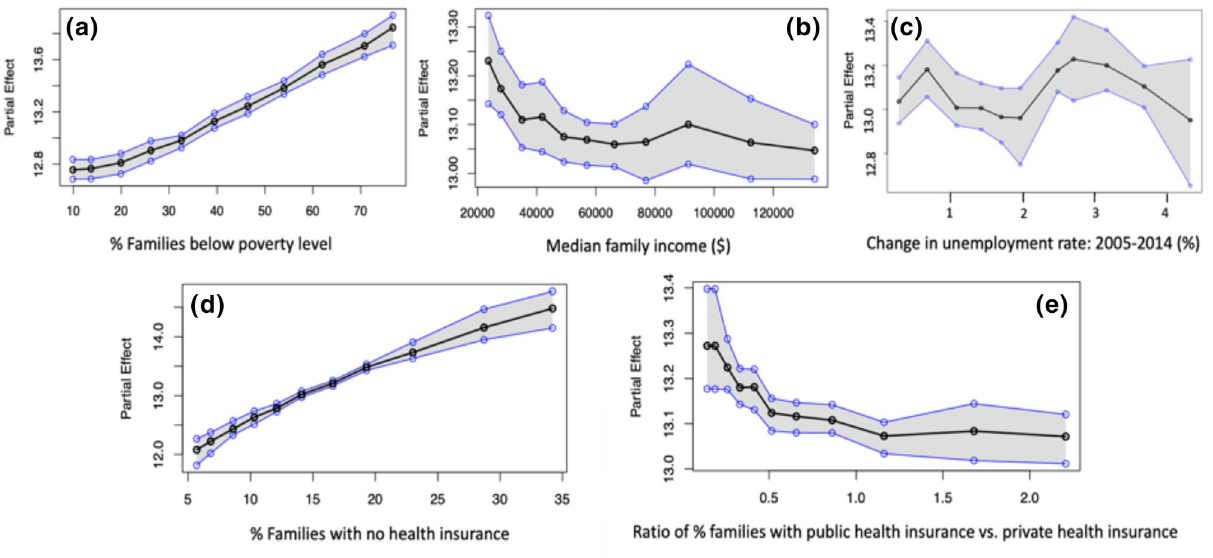
Figure 1. Partial Dependence Plots (PDPs) of the key socio-economic aspects of the built environment: ( a ) % of families below poverty level, ( b ) median family income, ( c ) % change in unemployment rate, ( d ) % families with no health insurance, ( e ) ratio of % of families with public health insurance vs. private health insurance. In each sub-figure, on the x - axis , the values of the particular independent variable is plotted, and on the y - axis , the partial effect of the independent variable on the response variable is depicted. The black curve is the average partial effect of the predictor variable and blue lines indicate the 95% confidence intervals.